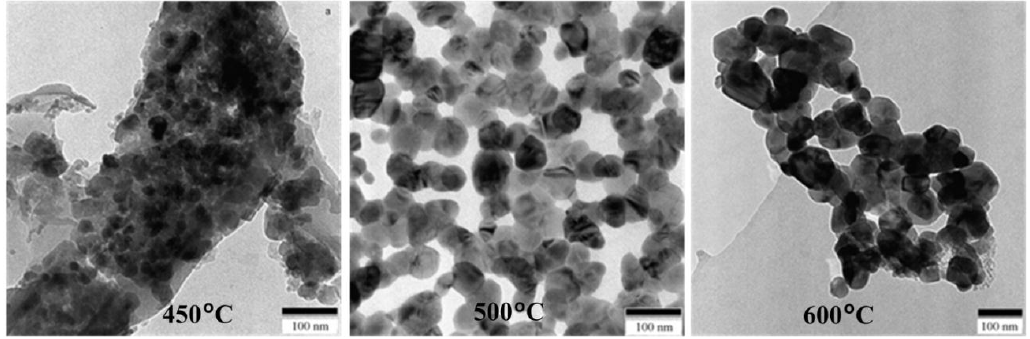
Figure 4. TEM micrographs of ZnO nanoparticles at different calcination